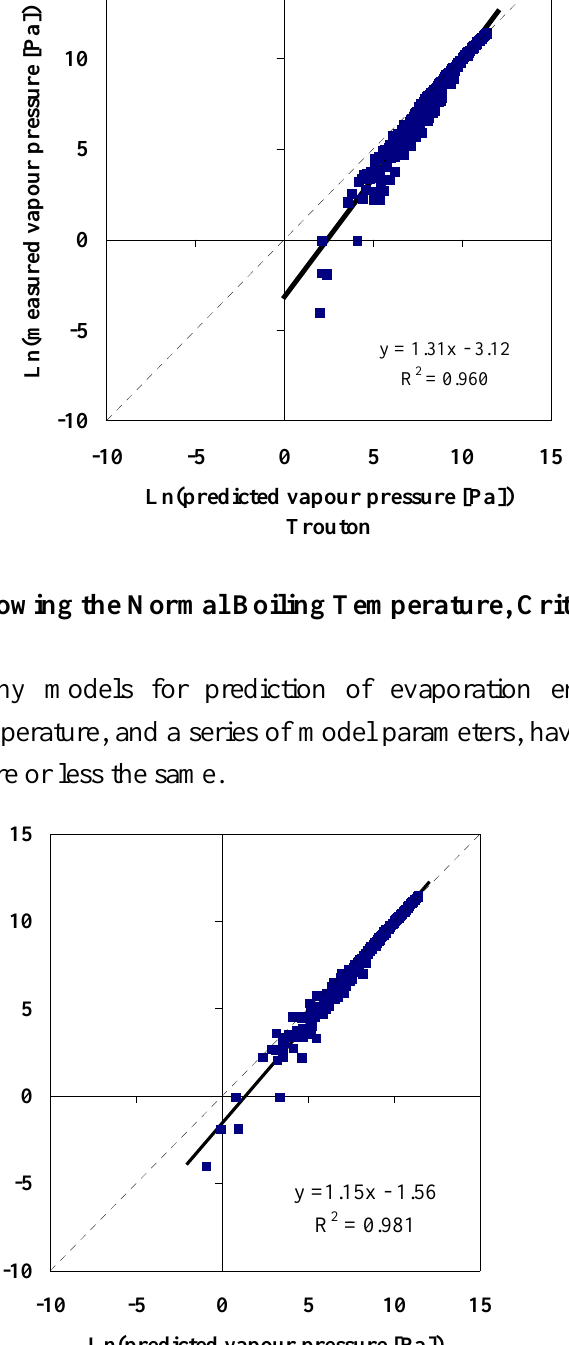
Figure 1. ln p predicted using Trouton’s rule for prediction of evaporation enthalpy. The line, which fits the data best, is of the general form: y = (1.31 ± 0.02) x - (3.12 ± 0.13).